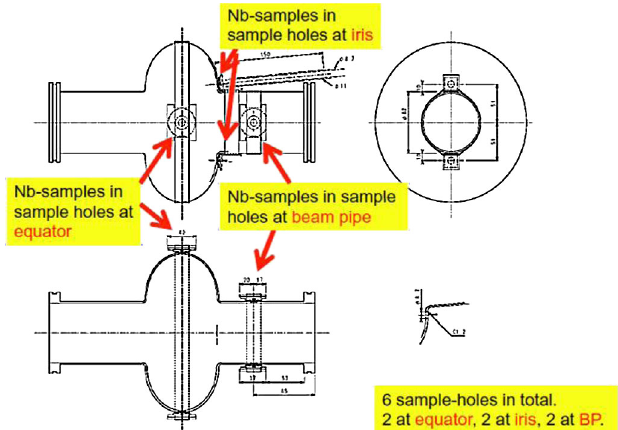
.*Correspondent author.